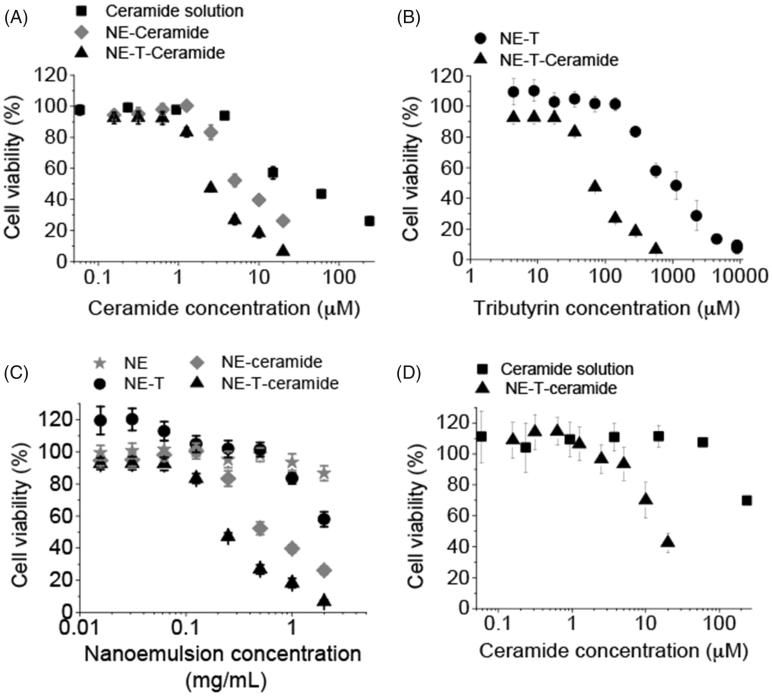
Cytotoxicity of the nanoemulsion (NE) and C6 ceramide. (A) influence of ceramide nanoencapsulation in nanocarriers without (NE) or with tributyrin (NE-T) on the cytotoxicity against MCF-7 cells, (B) influence of tributyrin incorporation and association with ceramide on nanocarrier cytotoxicity against MCF-7 cells; (C) comparison of nanocarrier cytotoxicity with and without ceramide and tributyrin, (D) influence of ceramide nanoencapsulation in nanocarriers without (NE) or with tributyrin (NE-T) on the cytotoxicity against RPE cells. Experiments were performed in triplicate and repeated 3–5 times; data shown as average ± standard error.